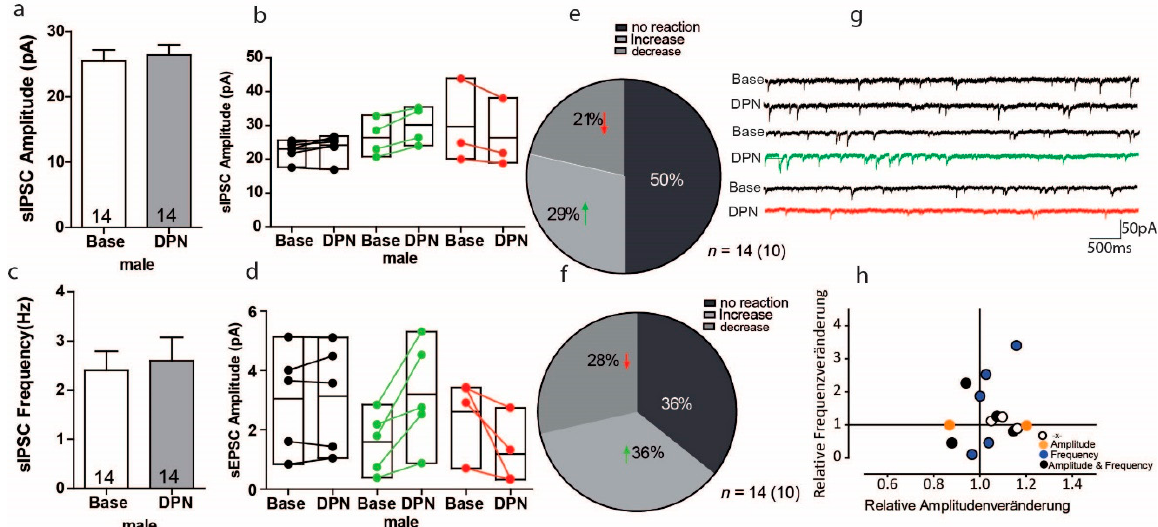
Figure 6. Activation of ERß on inhibitory transmission in the PFC of male mice. ( a , c ) No significant changes in the average sIPSC amplitude and sEPSC frequency recordings were found in the mPFC during baseline and after DPN treatment. ( b , d ) Within-cell analyses showed that activation of ERß led to opposing reactions in the sIPSC amplitude and frequency in a subset of cells. ( e , f ) The proportion of cells with a significant response to DPN treatment. ( g ) Sample traces, frequencies and amplitudes of sEPSCs before and after DPN treatment. ( h ) No correlations were found between changes in sIPSC frequency and sIPSC amplitude.